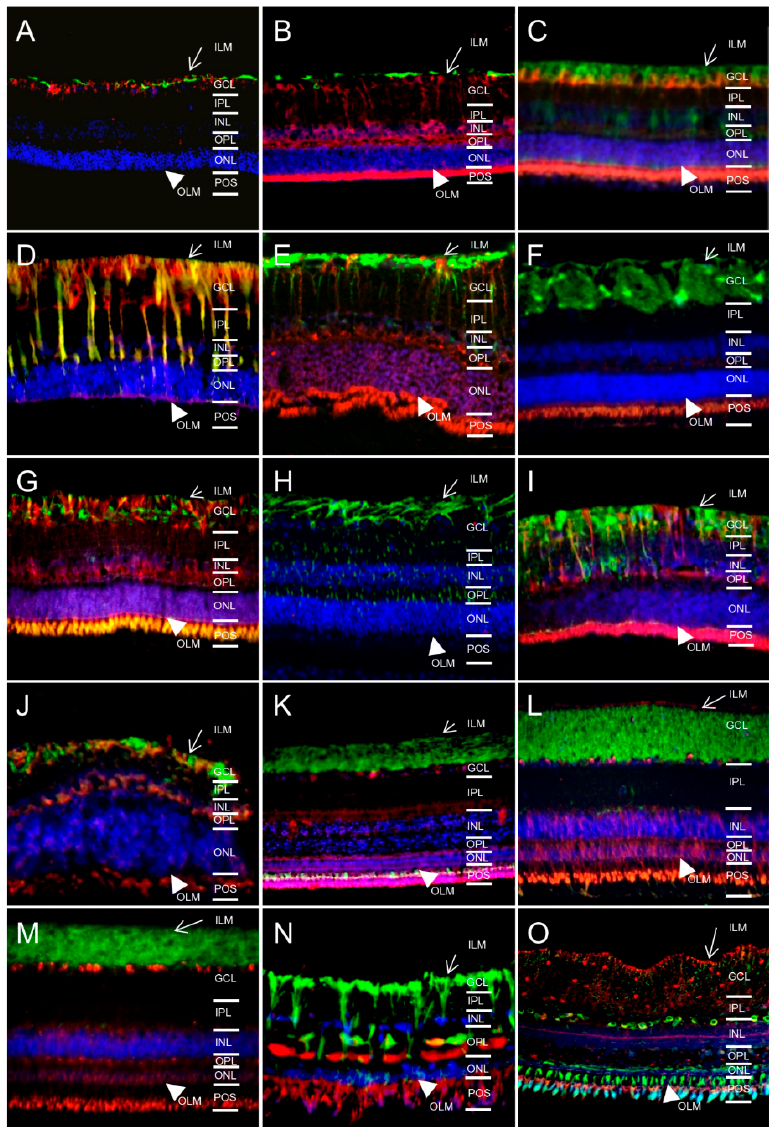
Figure 4. Overlay (yellow) of AQP11 (red) with Muller glial cell marker glial fibrillary acidic protein (GFAP, green; magnification ×40). ILM, inner limiting membrane (arrow); GCL, ganglion cell layer; IPL, inner plexiform layer; INL, inner nuclear layer; OPL, outer plexiform layer; ONL, outer nuclear layer; OLM, outer limiting membrane (arrowhead); POS, photoreceptor outer segments. ( A ) mouse; ( B ) rat; ( C ) guinea pig; ( D ) horse; ( E ) cow; ( F ) sheep; ( G ) deer; ( H ) pig; ( I ) cat; ( J ) dog; ( K ) pigeon; ( L ) chicken; ( M ) pheasant; ( N ) sturgeon; ( O ) char. Cell nuclei: blue (DAPI).